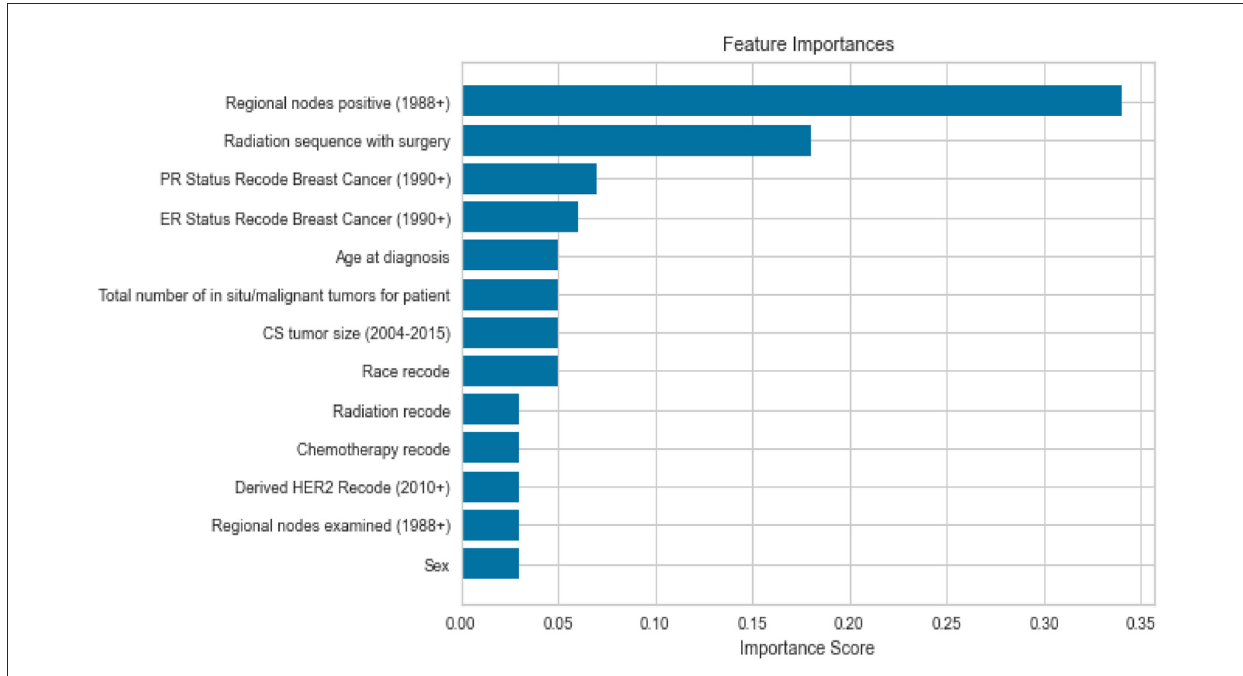
FIGURE4 Feature